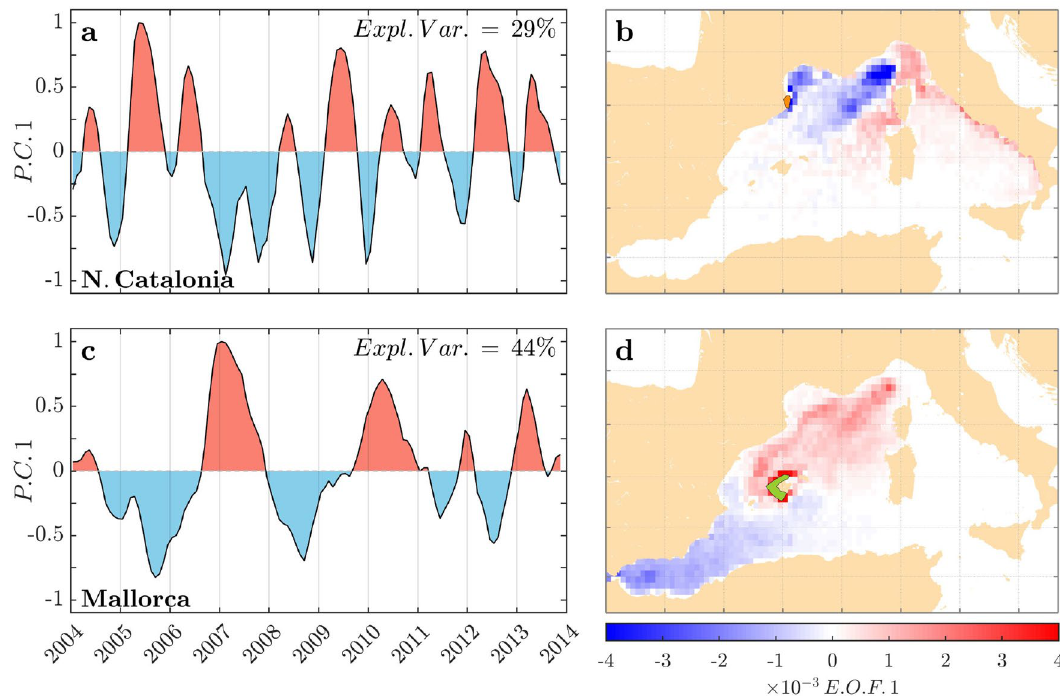
Figure 3. Prevailing sources and interannual patterns of LPDP arriving at the target areas after eight months. Temporal ( a , c ) and spatial ( b , d ) representation of the first principal component (PC1) of empirical orthogonal function (EOF) analysis conducted on source areas of individuals based on 120 monthly origin maps (2003– 2014) (more details in “Methods”). The results are for N. catalonia ( a , b ) and Mallorca ( c , d ). The total explained variance was 29% for N. Catalonia and 44% for Mallorca. Positive PC and EOF values are in red, and negative values are in blue. Original source maps can be reconstructed using the climatology (Fig. 1b,c) and adding the product of PC1 by EOF values. Therefore, intensified influence as source areas emerges when blue/red areas (from EOF value) and PC value match (blue/red). The figure and superimposed maps were created using “M Map: A mapping package for MATLAB”, v.1.4m (www. eoas. ubc. ca/ ~rich/ map. html) in MATLAB v.R2010b (www. mathw orks.